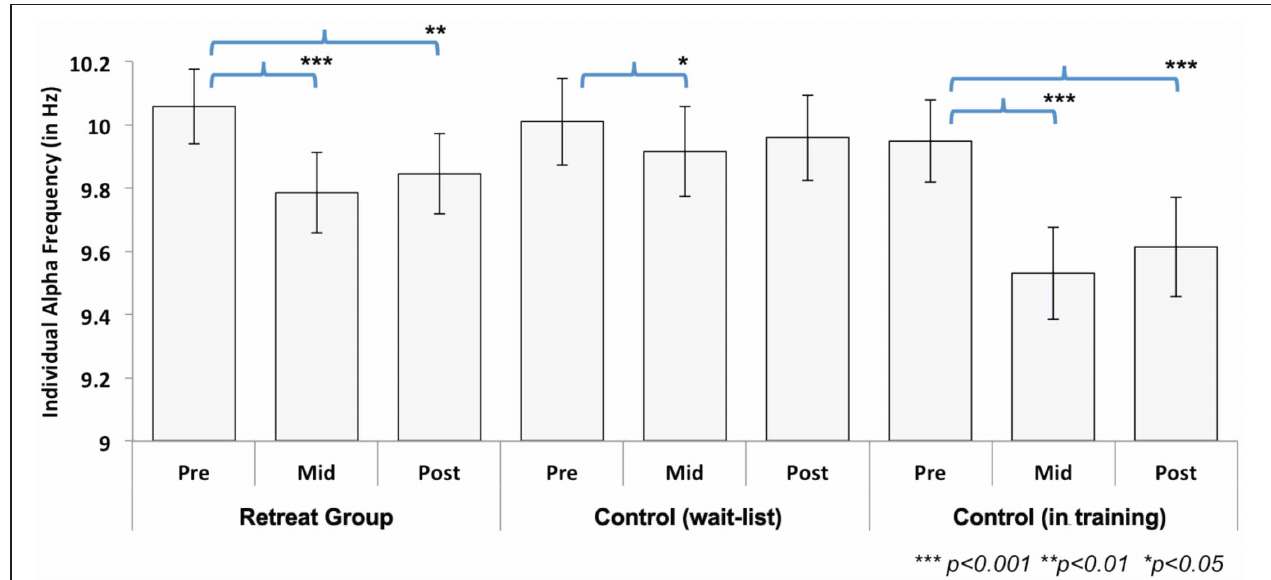
FIGURE 4 | Changeinindividualalphafrequency(IAF)acrossassessments duringRetreat 1 (Retreat andControlgroup)andRetreat 2 (Controlgroup intraining). The figure showsIAFvalues, averaged across participants, ineach